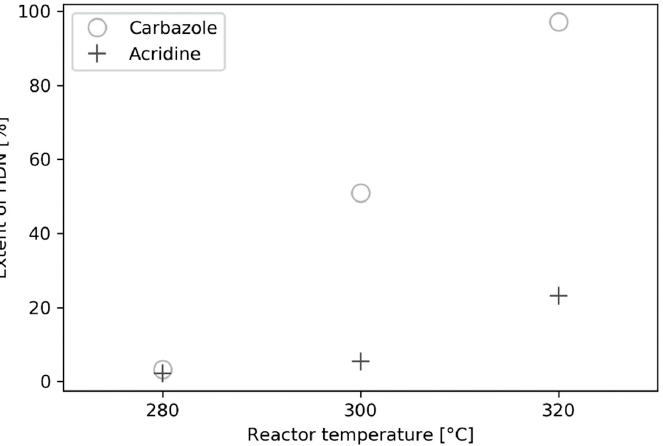
Figure 5. Phenanthrene product distribution with 1.2 mmol/dm 3 organic nitrogen (carbazole or acridine) present in the reactant feed at a reactor temperature of 320 ◦ C.